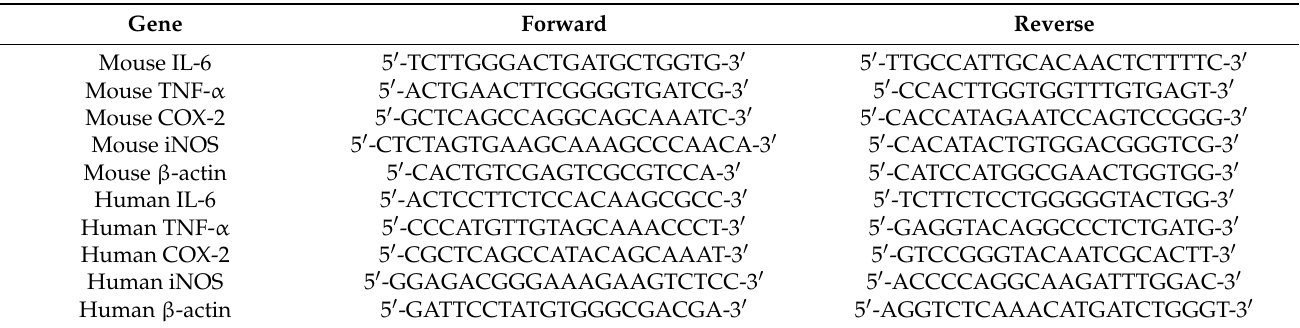
Table 1. The sequences for qPCR primers used in this